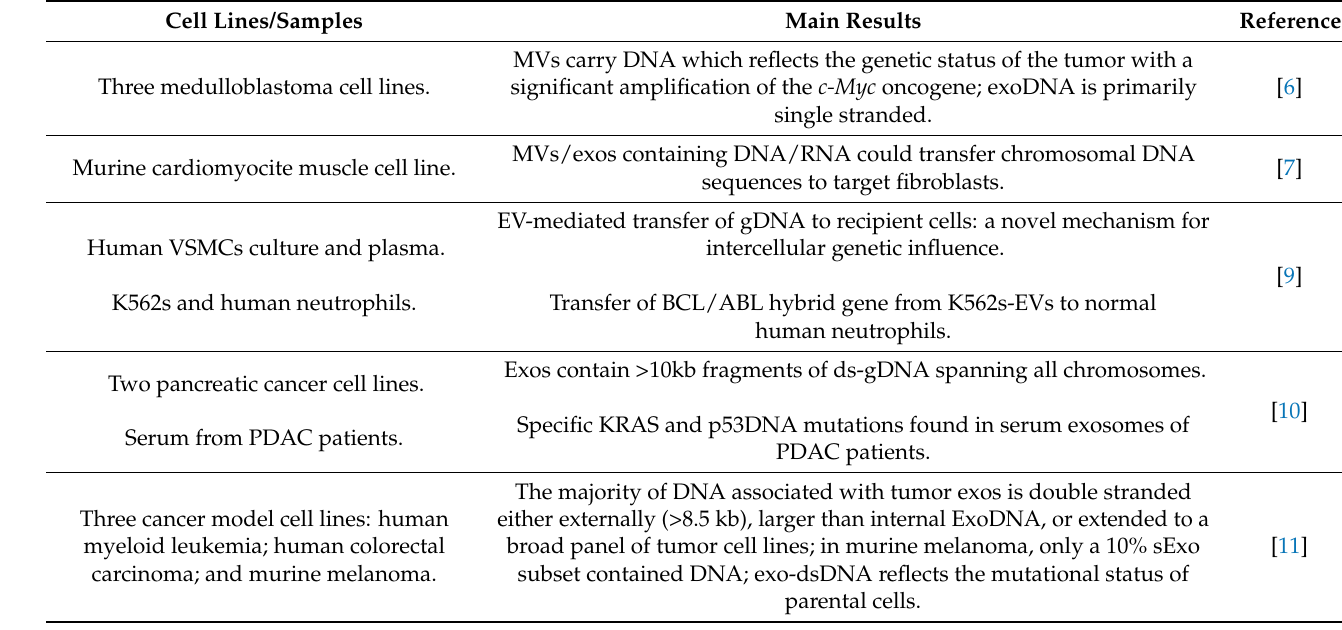
Table 1. Precursor studies on the DNA content of cell-derived EVs